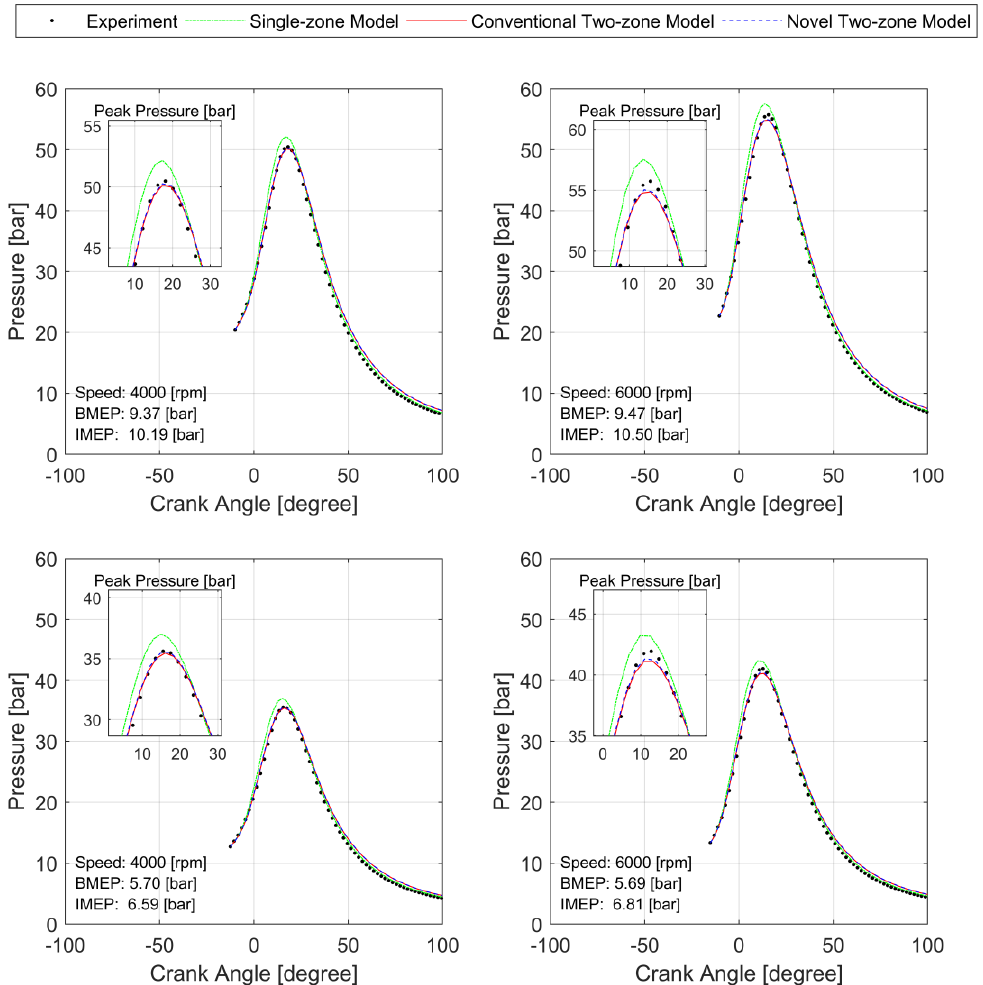
Figure 6. Experimental and simulated in-cylinder pressure.